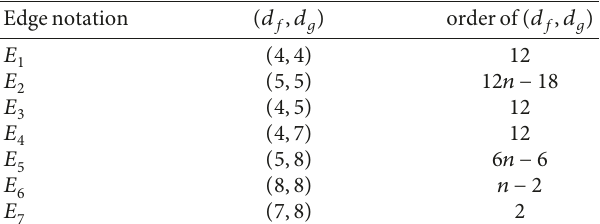
Table 1: Degree-based edge partition.